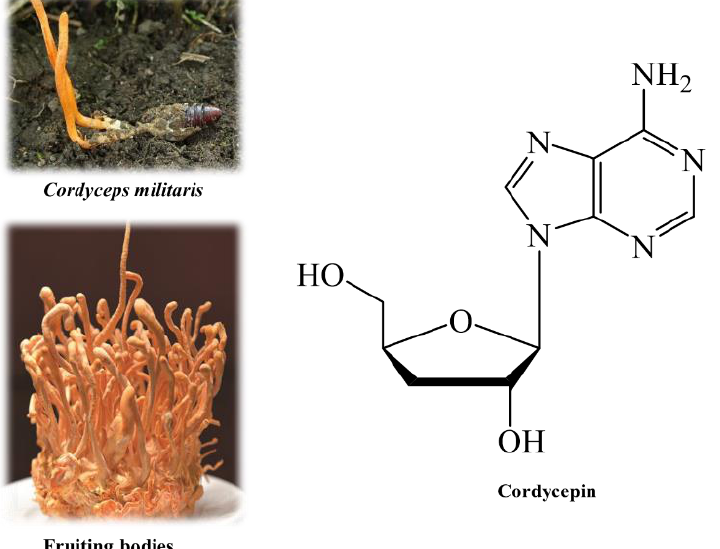
Figure 1. Cordyceps militaris , fruiting bodies, and cordycepin. Though possessing valuable health benefits, the isolation and purification of cordy- cepin from biomass as well as in cultural media has never been simple so far. Presently, most of the protocols have reported complicated processes, which might be costly and laborious. Though a variety of approaches for cordycepin synthesis have been reported, some shortcomings are inevitable [9], such as applicability and feasibility on larger scales of production compared to the laboratory scale. Therefore, cordycepin derived from natural sources has remained an important position in the current demand. As a result, simplified isolation and purification methods are required to shorten the time and cost of production of cordycepin and cordycepin-included purities from the Cordyceps fungi. On the other hand, kombucha, a fermented functional beverage, has rapidly gained popularity since 1990 due to increasing health demands. In 2019, its market size in the world exceeded 1.8 billion dollars [10]. Many studies have confirmed the biological activi- ties of kombucha products as antioxidant, antibacterial, antifungal, hepatoprotective, and anticancer [11–13]. Along with traditional black and green teas, most kombucha products